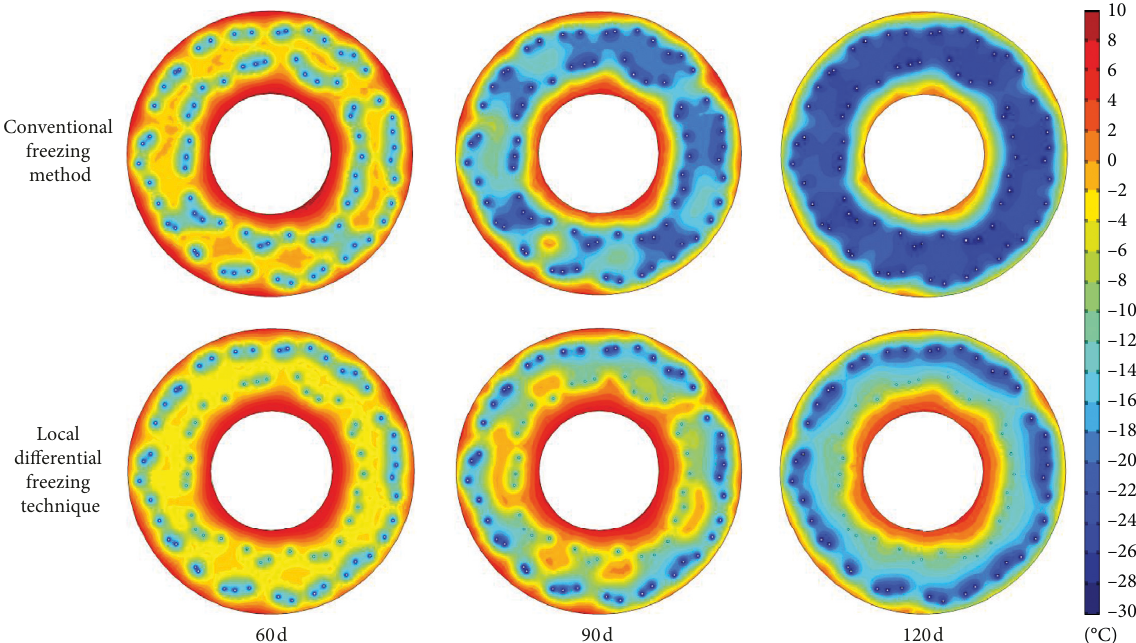
Figure 8: Comparison of the development law of the freezing temperature field before and after adopting the local differential freezing